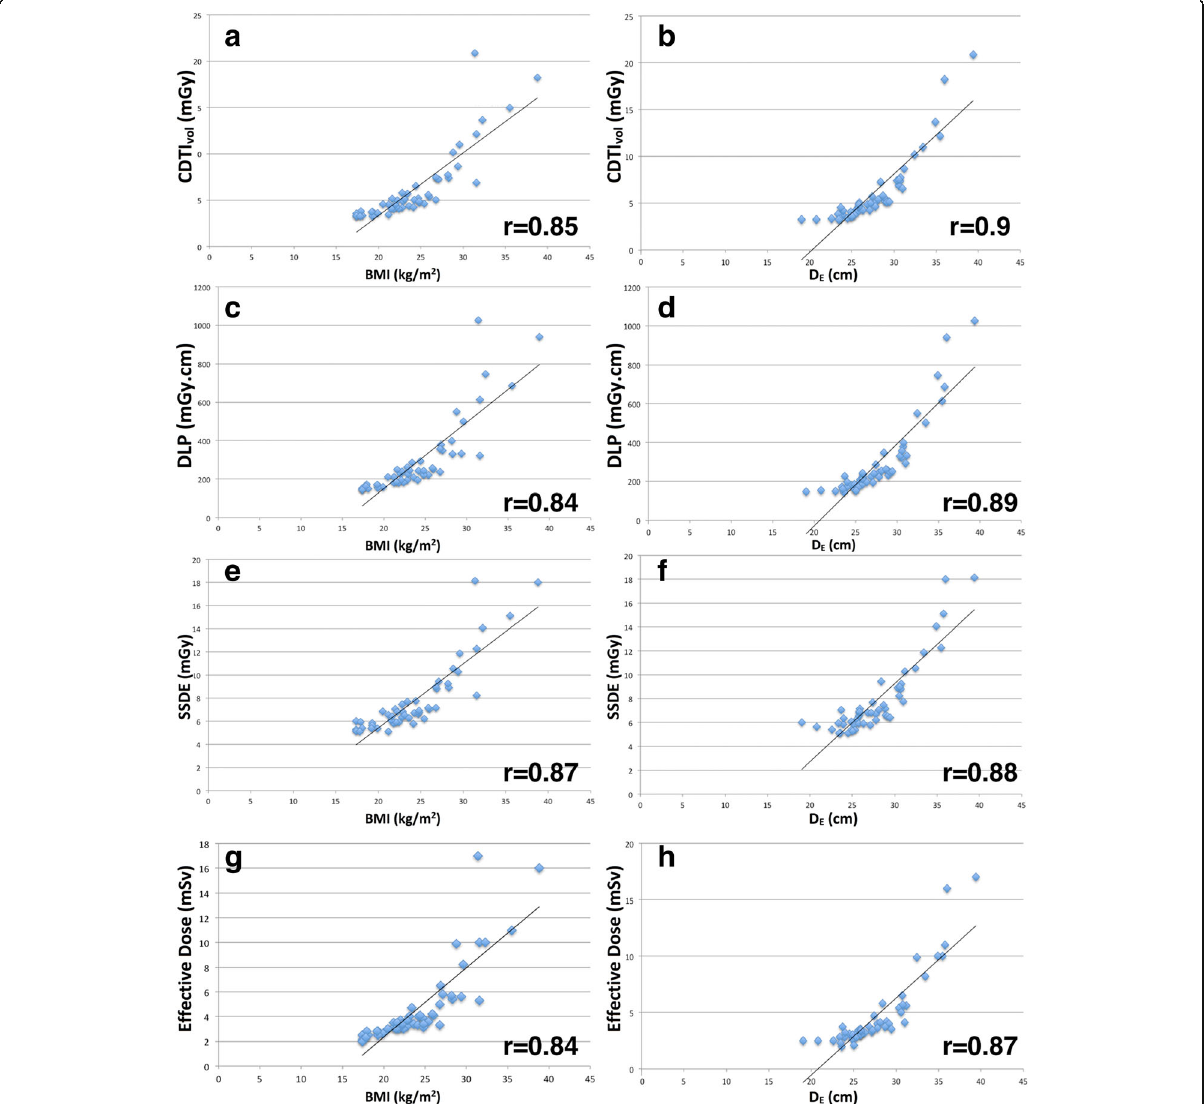
Fig. 3 Scatterplots show: volume-computed tomography dose index (CTDI vol ) for body mass index (BMI) ( a ) and effective diameter ( b ) with correlation r values of 0.85 and 0.9, respectively; dose length product (DLP) for BMI ( c ) and effective diameter ( d ) with r correlation values of 0.84 and 0.89, respectively; size-specific dose estimate (SSDE) for BMI ( e ) and effective diameter ( f ) with r correlation values of 0.87 and 0.88, respectively; effective dose for BMI ( g ) and effective diameter ( h ) with r correlation values of 0.84 and 0.87,